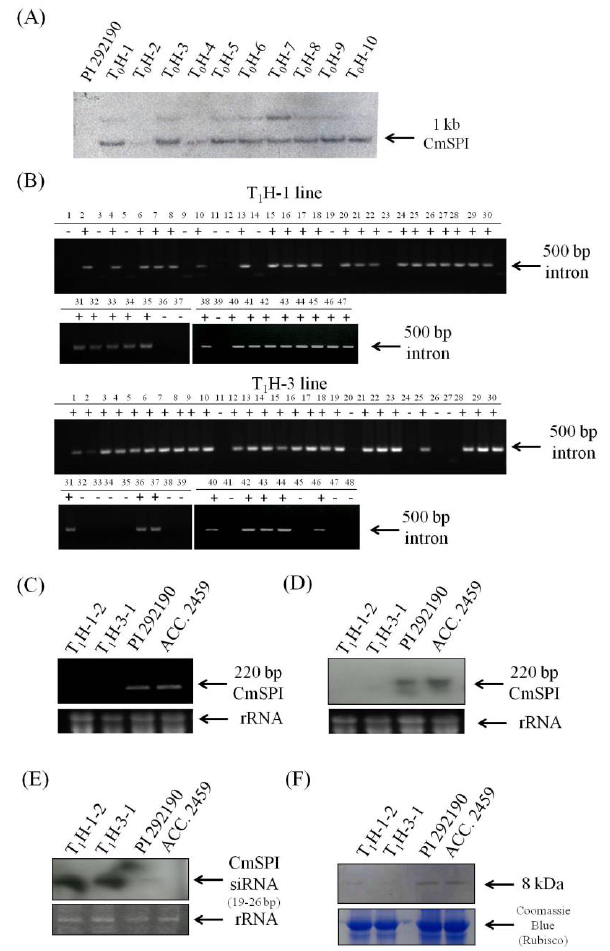
Figure 4. Generation of CmSPI RNAi trangsenic C. metuliferus . ( A ) Southern hybridization analysis of DNA isolated from RNAi T 0 transgenic lines (T 0 H-1 to T 0 H-10) with α 32 P-labeled intron fragment probe. C. metuliferus line PI 292190 was used as a negative control; ( B ) PCR analysis of two RNAi transgenic T 1 lines (T 1 H-1 and T 1 H-3 lines) with intron specific primers. +, transgenic plants; –, non-transgenic plants; ( C ) Transcript levels of CmSPI in C. metuliferus lines (PRSV-resistant line PI 292190 and PRSV-susceptible line Acc. 2459) and two T transgenic lines (T H-1-2 and T H-3-1). Total RNA from 1 1 1